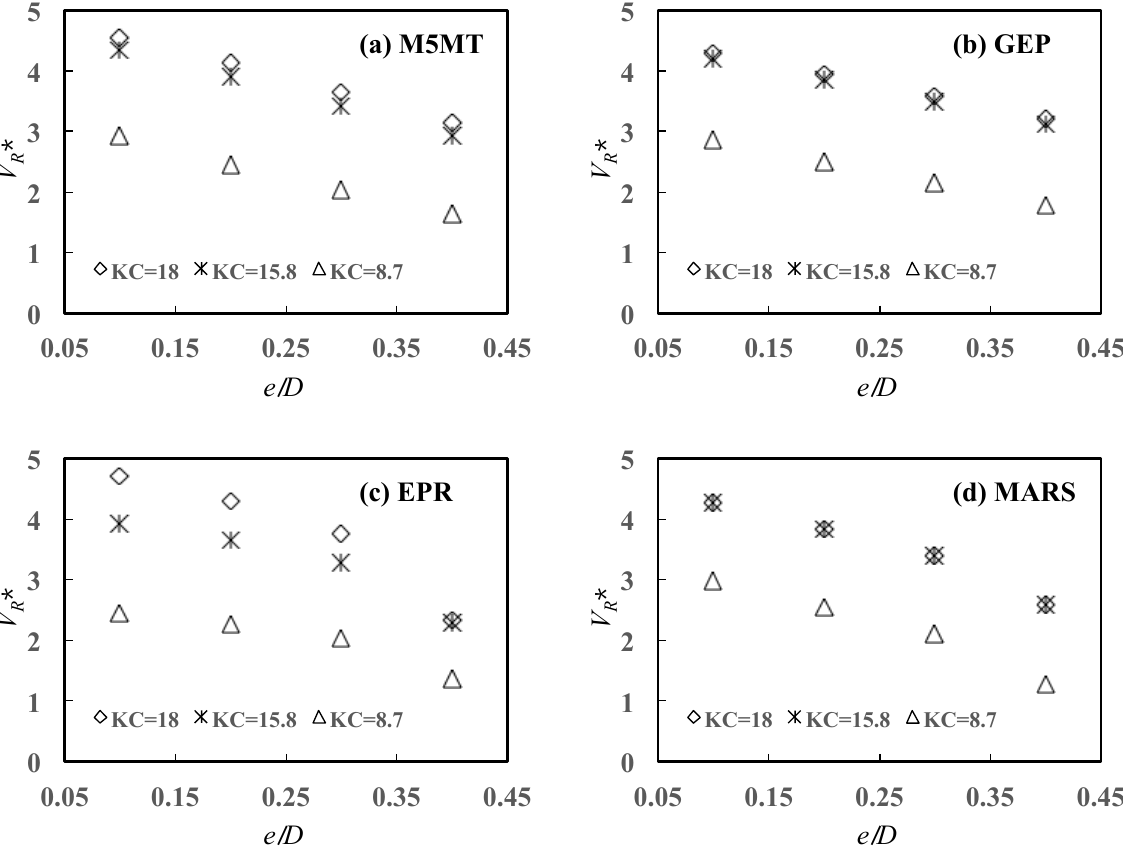
Table 5. SSE values for the considered AI models when predicting 𝑉 𝐻∗ at various 𝑒 𝐷⁄ ratios.